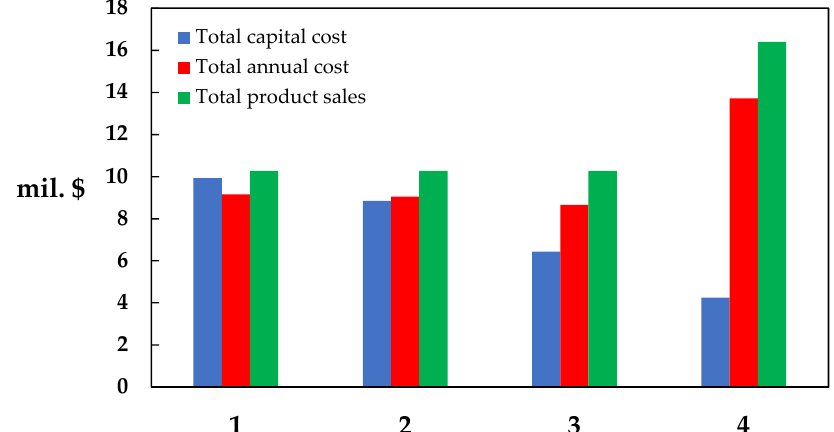
Figure 6. Total capital, total annual costs, and product sales for individual case studies;